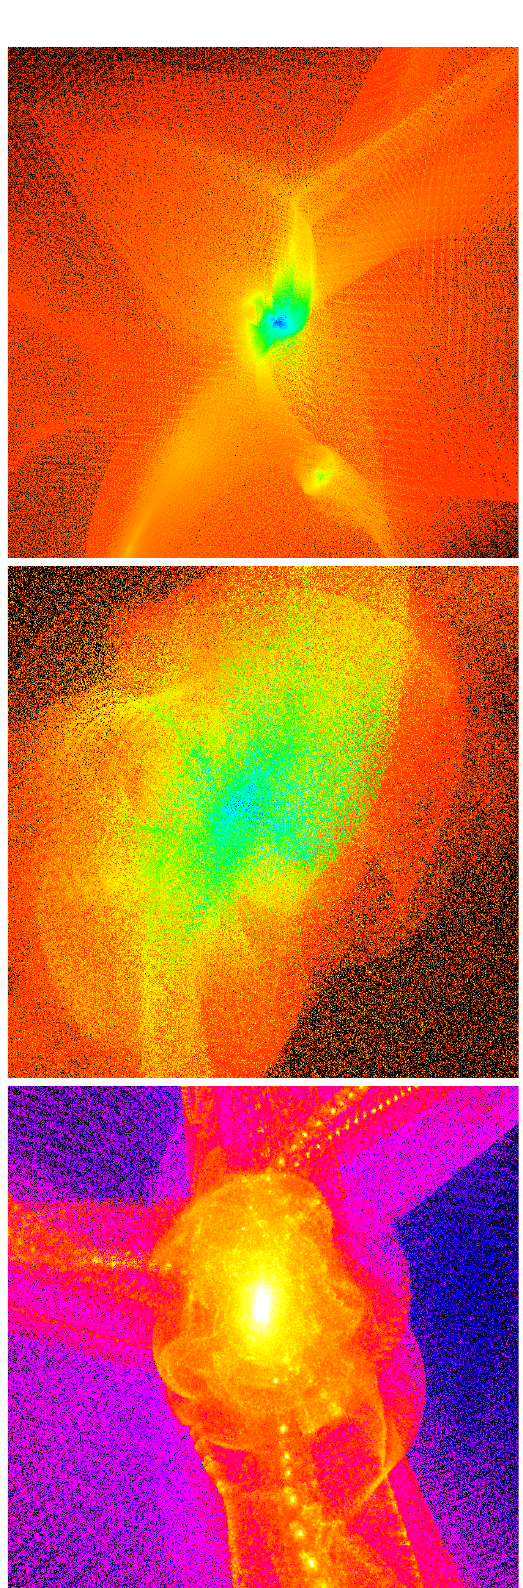
Figure 2. A magnitude plot of the radial velocities in the high-resolution collapse region ( upper panel ) and halo center ( middle panel ). A zoom in the high-resolution refined 7 × 10 12 M (cid:12) halo that formed top-down ( lower panel ) where the caustics and shells are clearly visible